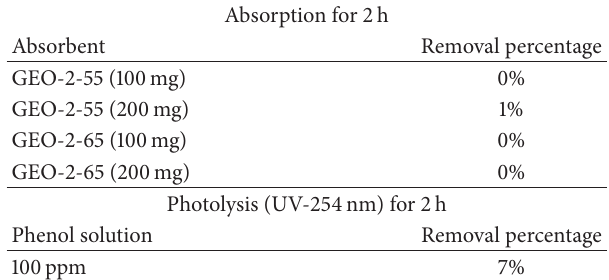
Table 3: Removal percentage of phenol in water by absorption test using GEO-2-55 and GEO-2-65 and in the photolysis